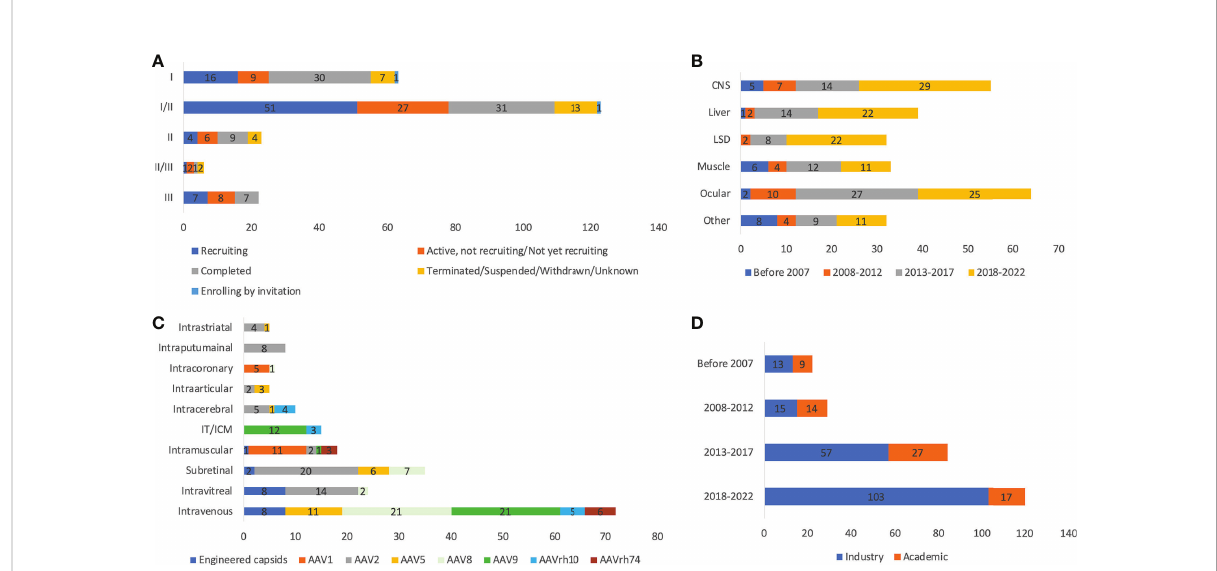
FIGURE 1 Basic information of 255 AAV clinical trials by status and phases (A) , disease indications (B) , ROAs and serotypes (C) , and sponsors (D) . ROA and serotypes associated with <10 trials are not included in the fi gure. IT and ICM were combined due to the high similarity. Unknown